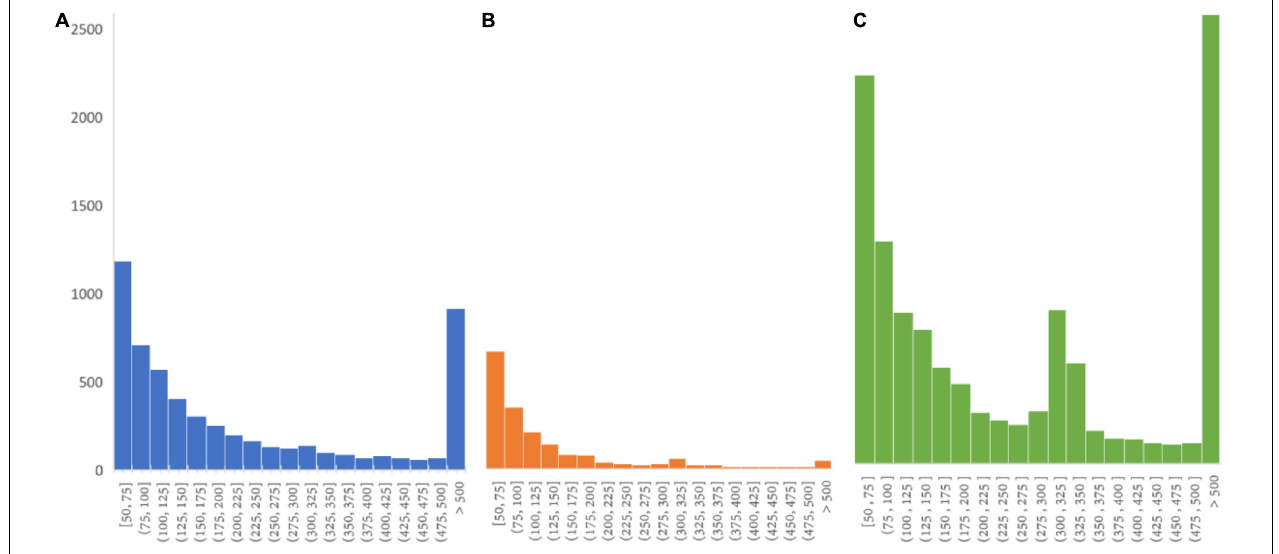
FIGURE 4 | SV length distribution of insertions from HG00512 126 × 2 sample. (A) Insertion length distribution of PanSVR true positive set (917 insertions longer than 500 bp); (B) Insertion length distribution of manta true positive set (48 insertions longer than 500 bp); (C) Insertion length distribution of CCS SV set (2,660 insertions longer than 500